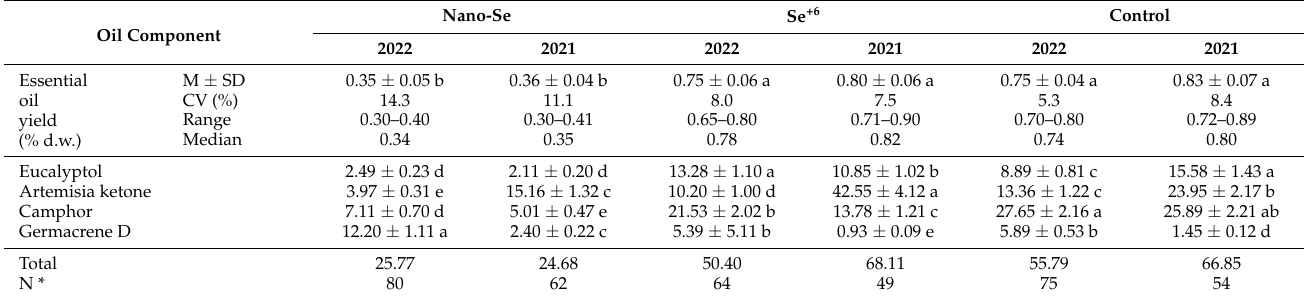
Table 4. A. annua essential oil yield and composition of the control plants and plants supplied with sodium selenate and